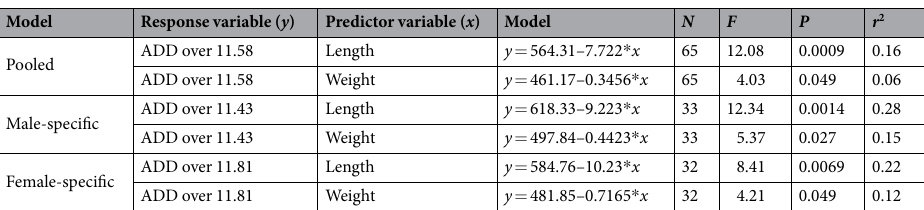
Table 1. Linear regression models for the relationship between length or weight of adult C. maxillosus at emergence and thermal summation values (accumulated degree days, ADD) needed to reach the adult